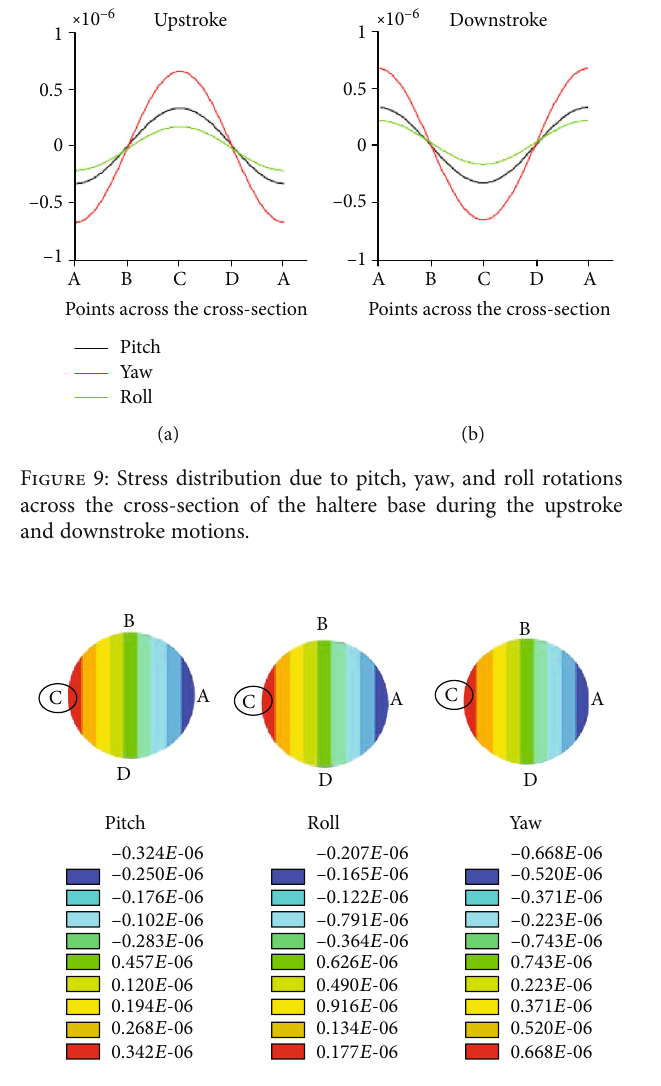
Figure 10: Stress distribution due to pitch, yaw, and roll rotations across the cross-section of the haltere base during the upstroke motion.